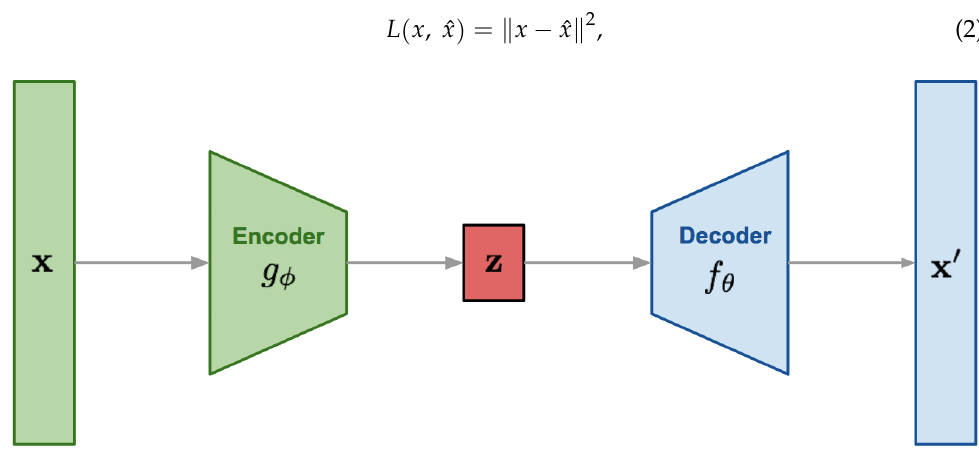
Figure 6. Examplary structure of